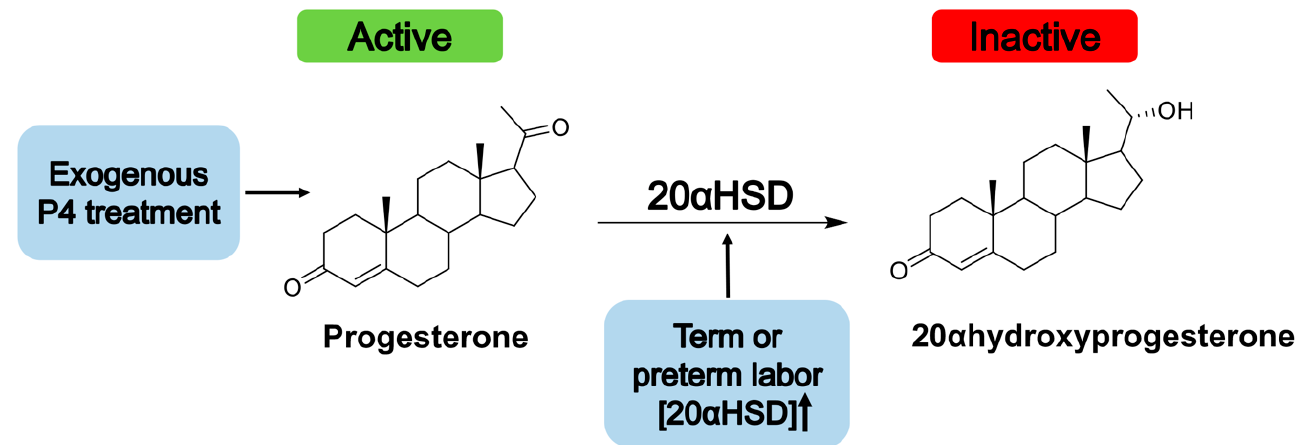
Figure 2. Elevated progesterone metabolism by 20 α HSD occurs at the onset of labor. At the onset of parturition, 20 α HSD expression is upregulated, and this leads to increased P4 metabolism. This impedes the ability of P4 to bind its ligand, PR-B, and maintain a quiescent pregnancy state. Instead, unliganded PR-A produces proinflammatory effects leading to contractions. For these reasons, exogenous P4 would be largely metabolized and therefore unable to exert the suppressive effects on contractions that the P4-PR-B complex accomplishes.